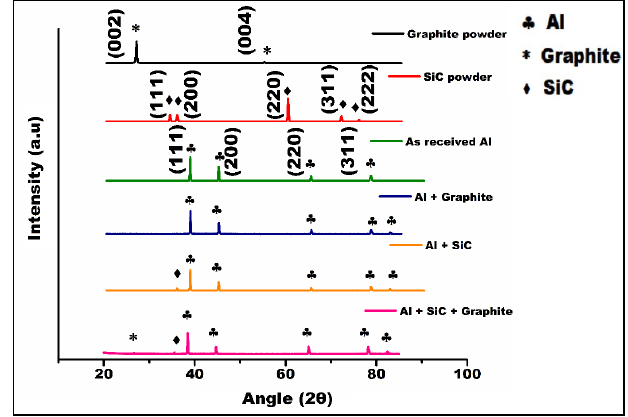
Figure 5. X-ray Diffraction ( XRD ) micrographs of as-received samples and friction stir processed